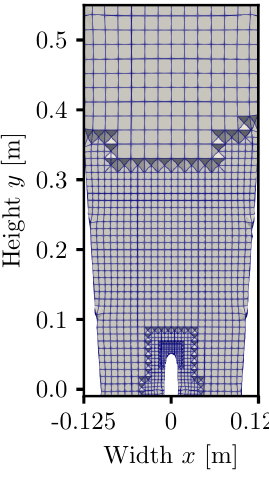
Figure 6. Mesh of for simulations of the GF3 lab-scale